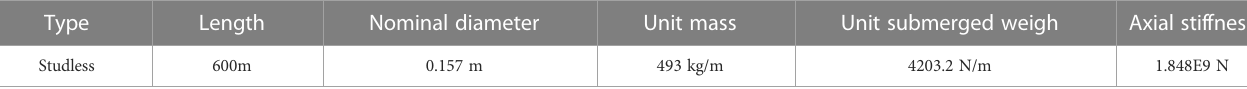
TABLE 4 The properties of mooring chains, adopted from van Rossum and Otto (2020).